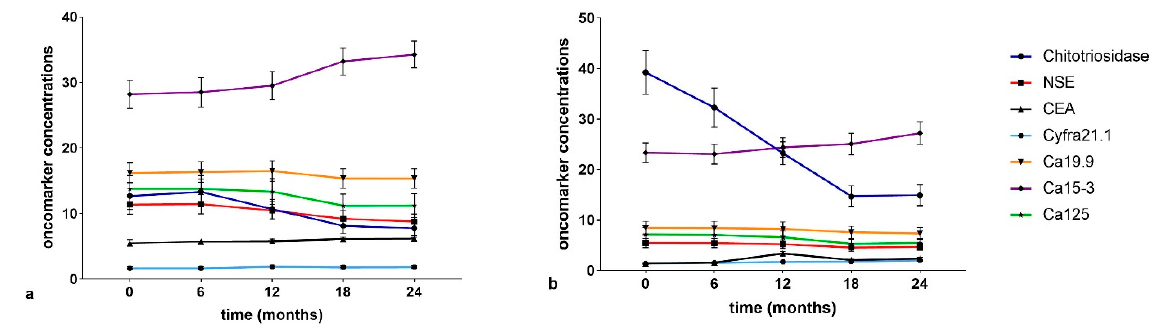
Figure 4. ( a ) Serial concentrations of oncomarkers in the IPF group. ( b ) Serial oncomarker concentrations in the non-IPF group.